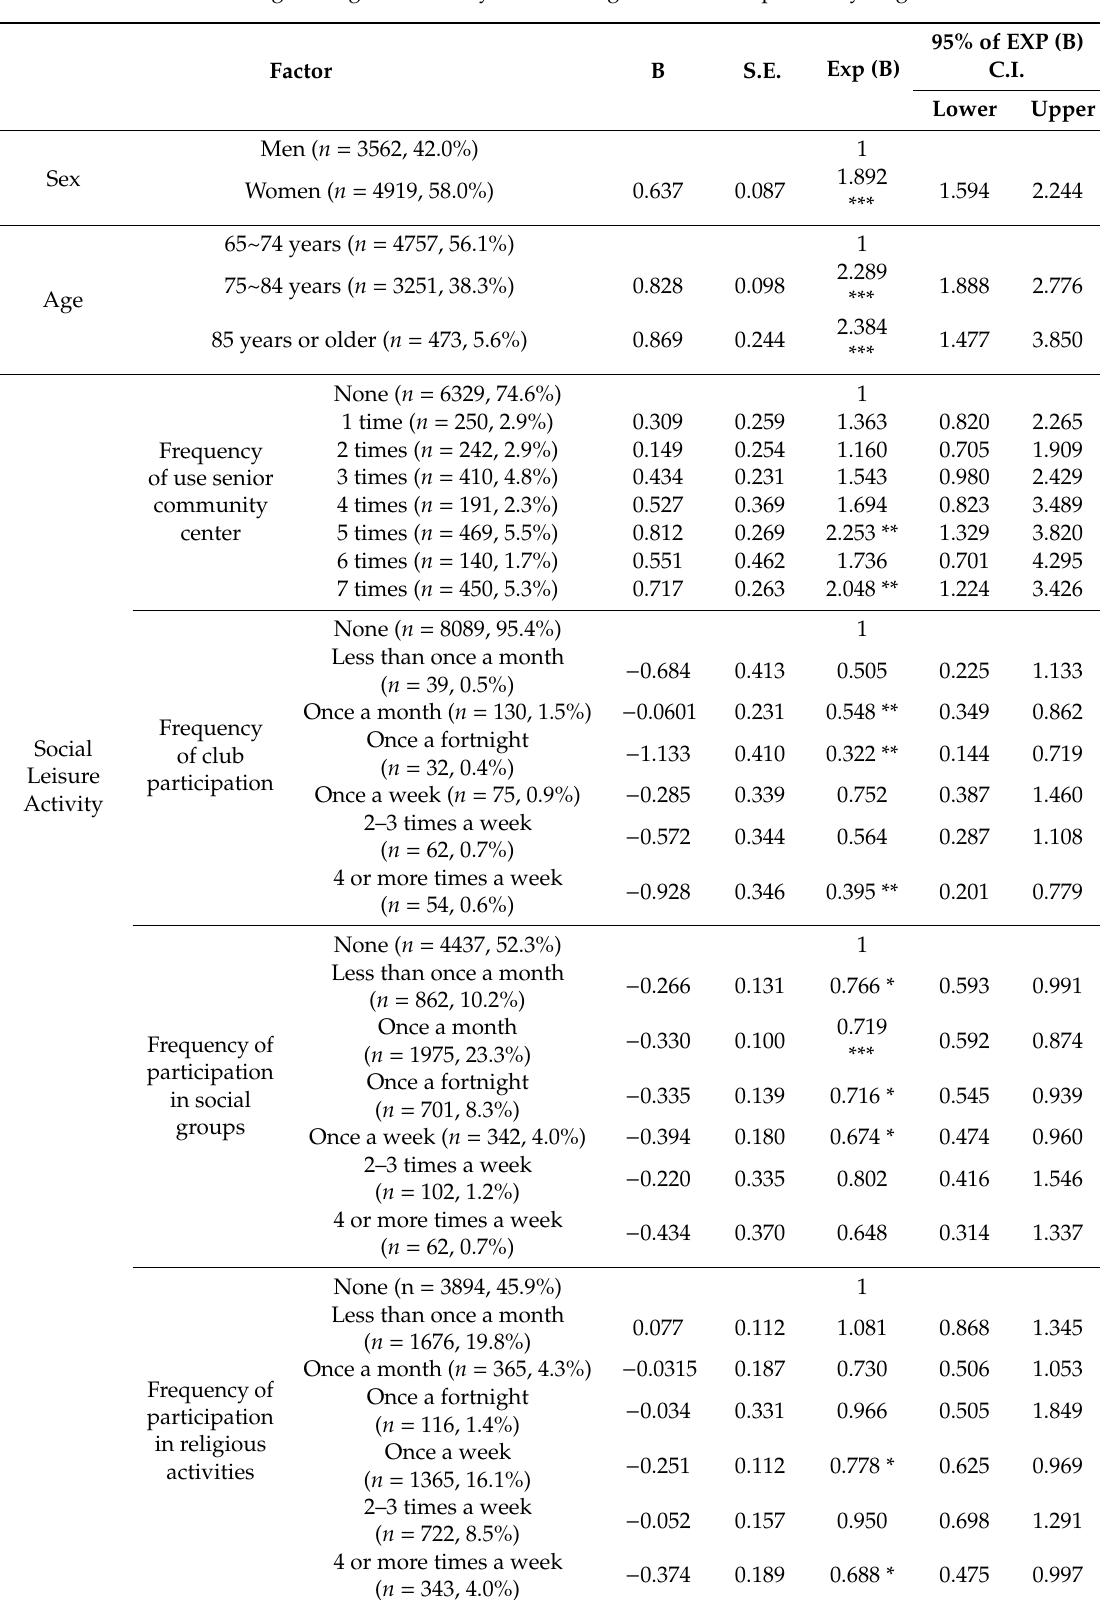
Table 5. Logistic regression analysis according to health and pre-frailty